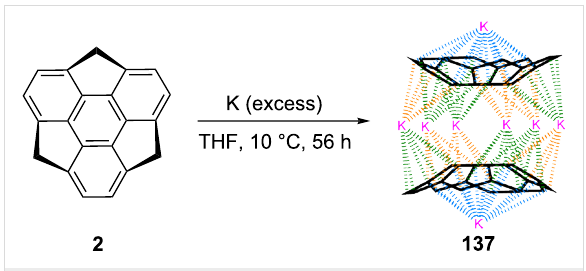
sized compound 134 was then treated with Ag 2 O in THF to afford the corresponding quinonediimine 135 in respectable yield. Furthermore, the stepwise coordination of the imino func- tionality of compound 135 to the palladium(II) was carried out in the presence of PdCl 2 (MeCN) 2 in a stepwise manner, con- firmed by UV–vis spectroscopic technique.